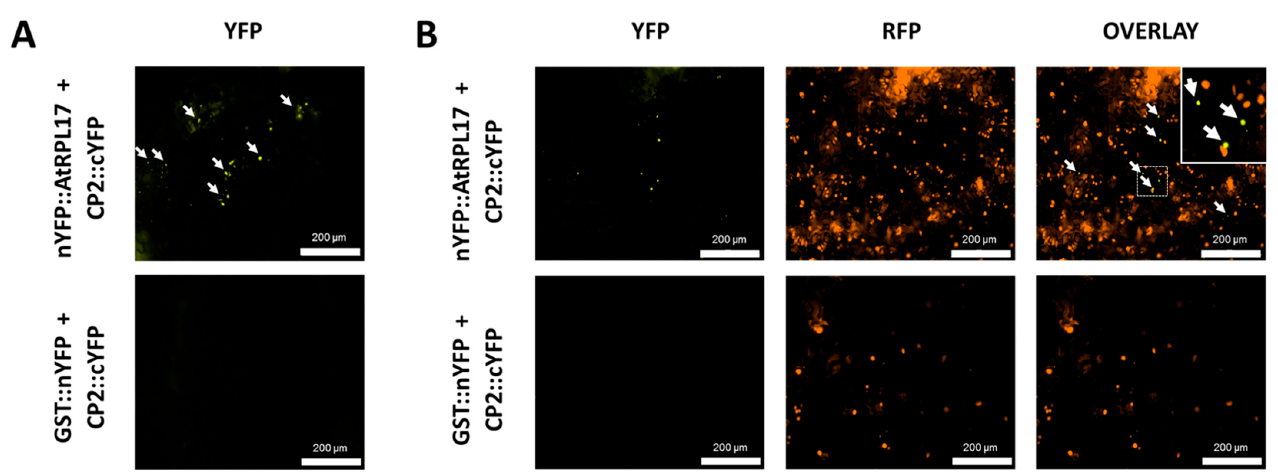
Figure 5. Interaction of At RPL17 and CP2 in Nicotiana benthamiana . ( A , B ) PMeV CP2- At RPL17 interaction in vivo by bimolecular fluorescence complementation (BiFC) in wild type ( A ) and transgenic N. benthamiana expressing RFP::H2B as a nuclear marker ( B ). Fusion proteins nYFP:: At RPL17 or GST::nYFP were expressed along with CP2::cYFP by agroinfiltration of the encoding plasmids into leaves of N. benthamiana . The reconstitution of yellow fluorescence was visualized 2 days post-infiltration. Fusion protein combinations expressed in each sample are indicated at the left of the corresponding row of images. Inset shows a detailed region of the nuclear marker and the reconstitution of yellow fluorescent protein. White arrows: interaction signals.